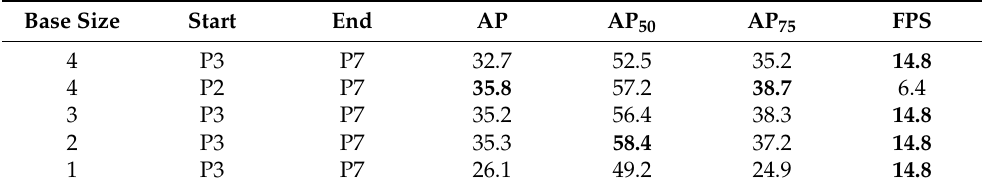
Table 4. Comparison of RetinaNet with varying octave base scales and different feature maps. Note that start and end indicate the first and last pyramid level used as feature map. Reducing the smallest anchor by either reducing the anchors’ base size or incorporating an earlier feature map in the detection head to accommodate the many small objects increases the AP. While incorporating an earlier feature map leads to the best average precision, it heavily impairs the FPS because of the processing of the high resolution feature map.